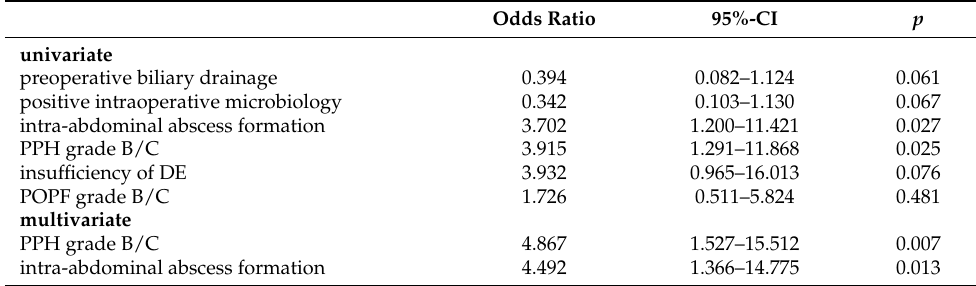
Table 3. Clinically relevant PF ◦ B/C—risk factors associated with high